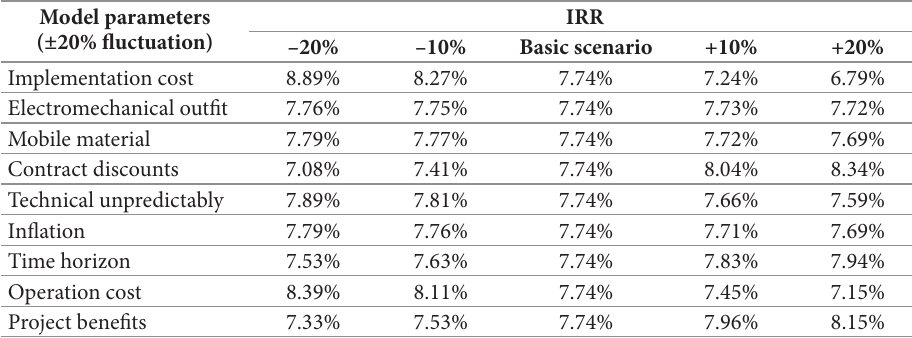
Table 3. Sensitivity analysis of the model parameters Model parameters (±20%